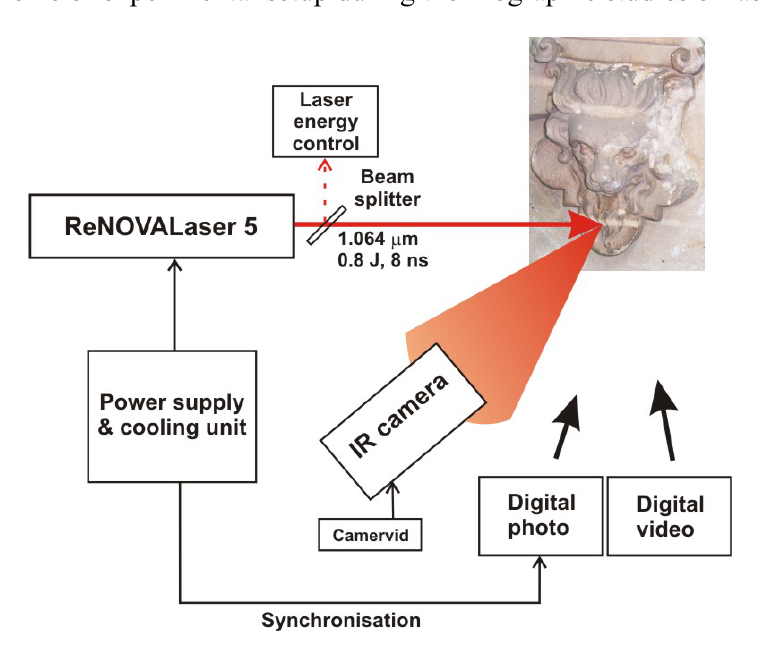
Figure 26. Scheme of experimental setup during thermographic studies of laser